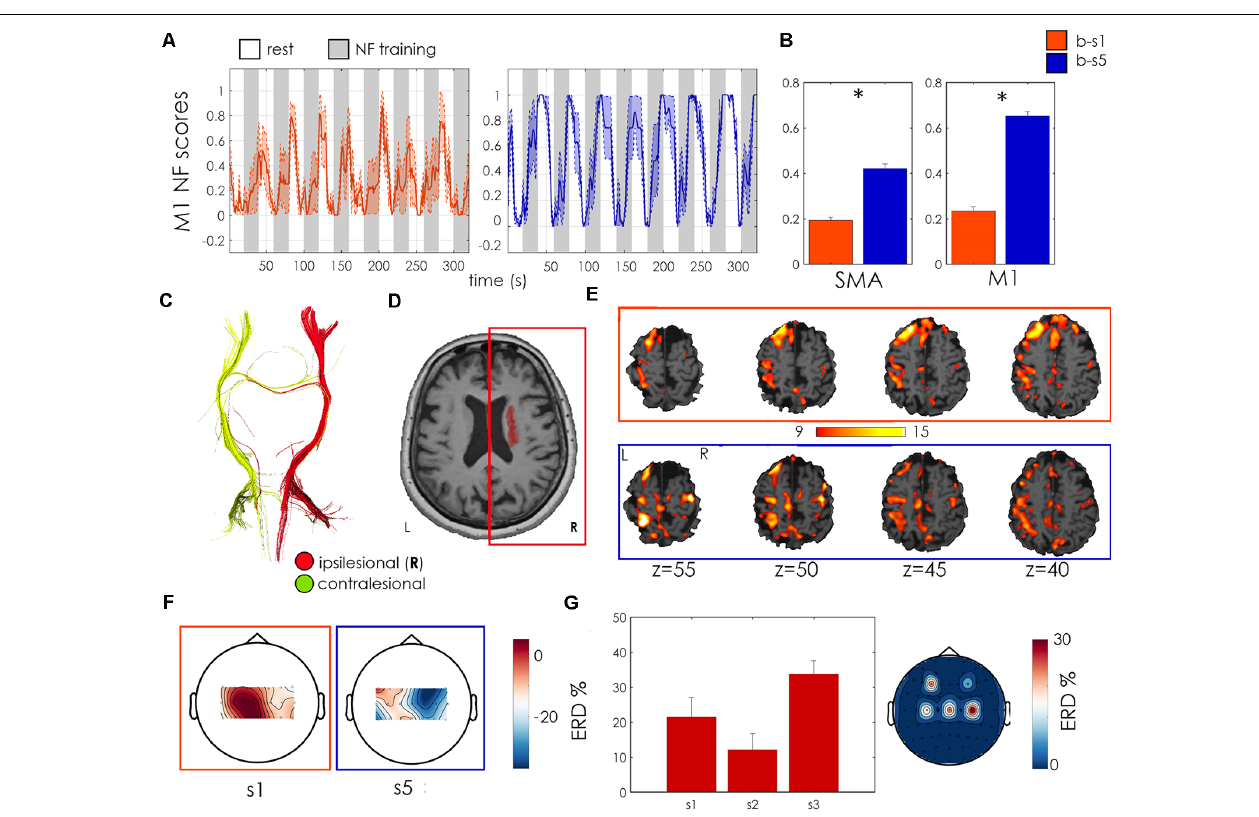
FIGURE 5 | Patient 02 outcome measures. Legend as for Figure 4